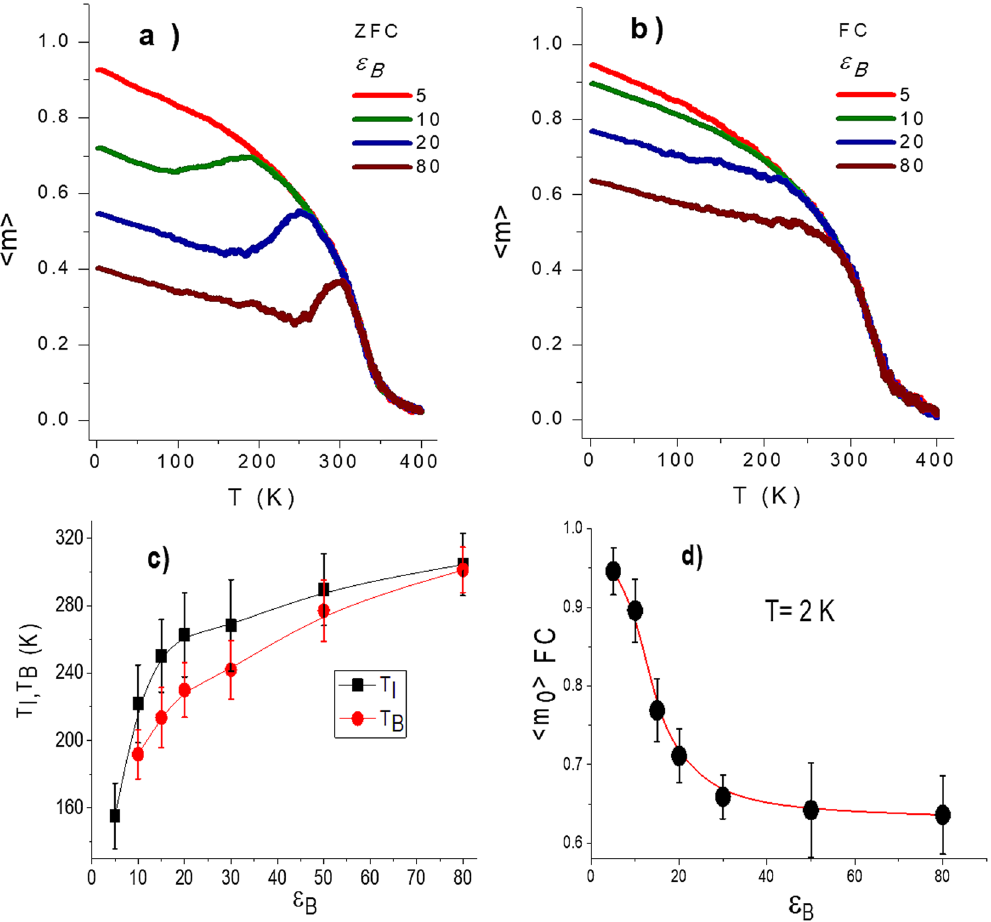
Figure 7. Influence of the strength of the boundary anisotropy ε ( b ) respectively. ( c ) Blocking and irreversibility temperatures as a function of ε dependence of the magnetization with ε